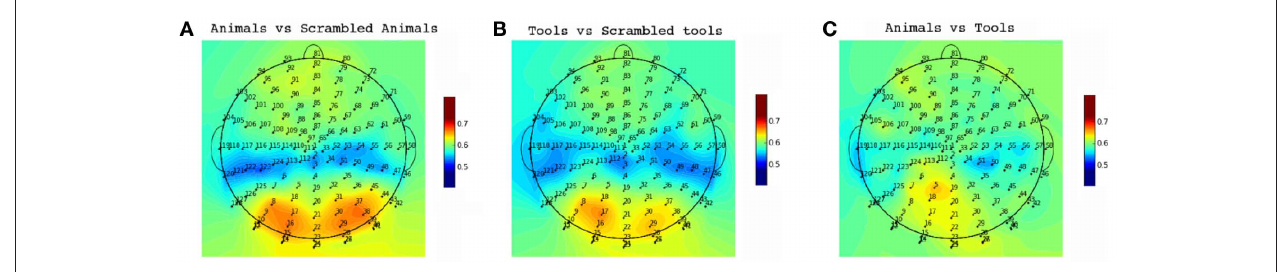
FiGurE 8 | Single Trial Channel Sensitivity. Classification accuracy for each channel for the conditions with seen targets. Each color represents the cross-validated accuracy of the classifier specific to each channel. For the